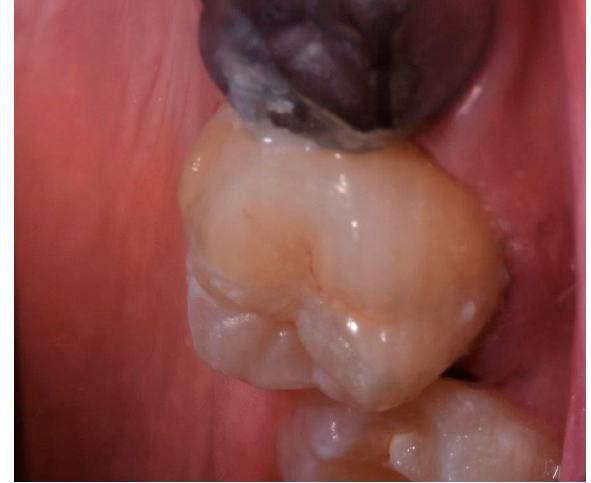
Figure 6. Cementation of restoration.